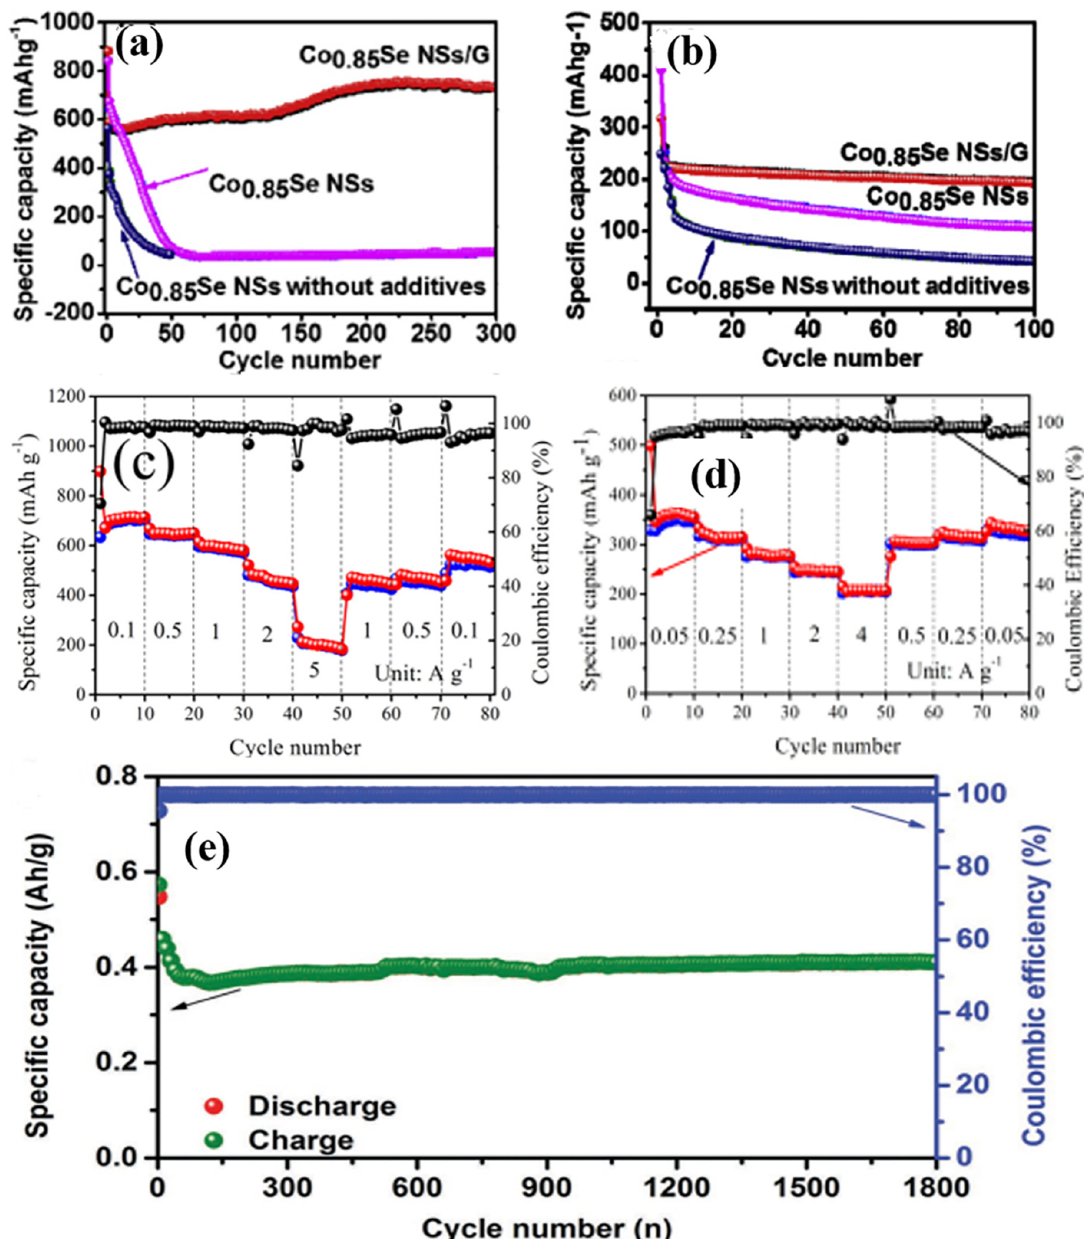
Figure 13. Electrochemical performances of cobalt-based anode materials. ( a ) Li-ion storage and ( b ) Na-ion storage cyclic performance of the Co 0.85 Se nanosheets/graphene (NSs/G) at 0.5 A g − 1 , in comparison with Co 0.85 Se NSs and Co 0.85 Se NSs without additives [160]. Rate performance of CoSe@PCP for ( c ) LIBs and ( d ) SIBs [68]. ( e ) Cyclic properties of CoSe 2 at 1 A g − 1 [190].